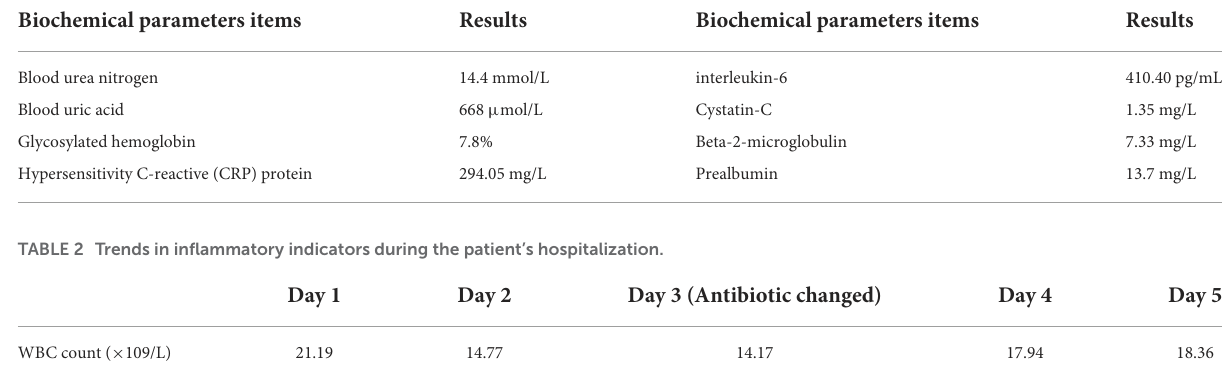
TABLE 1 Biochemical parameters of this patient.